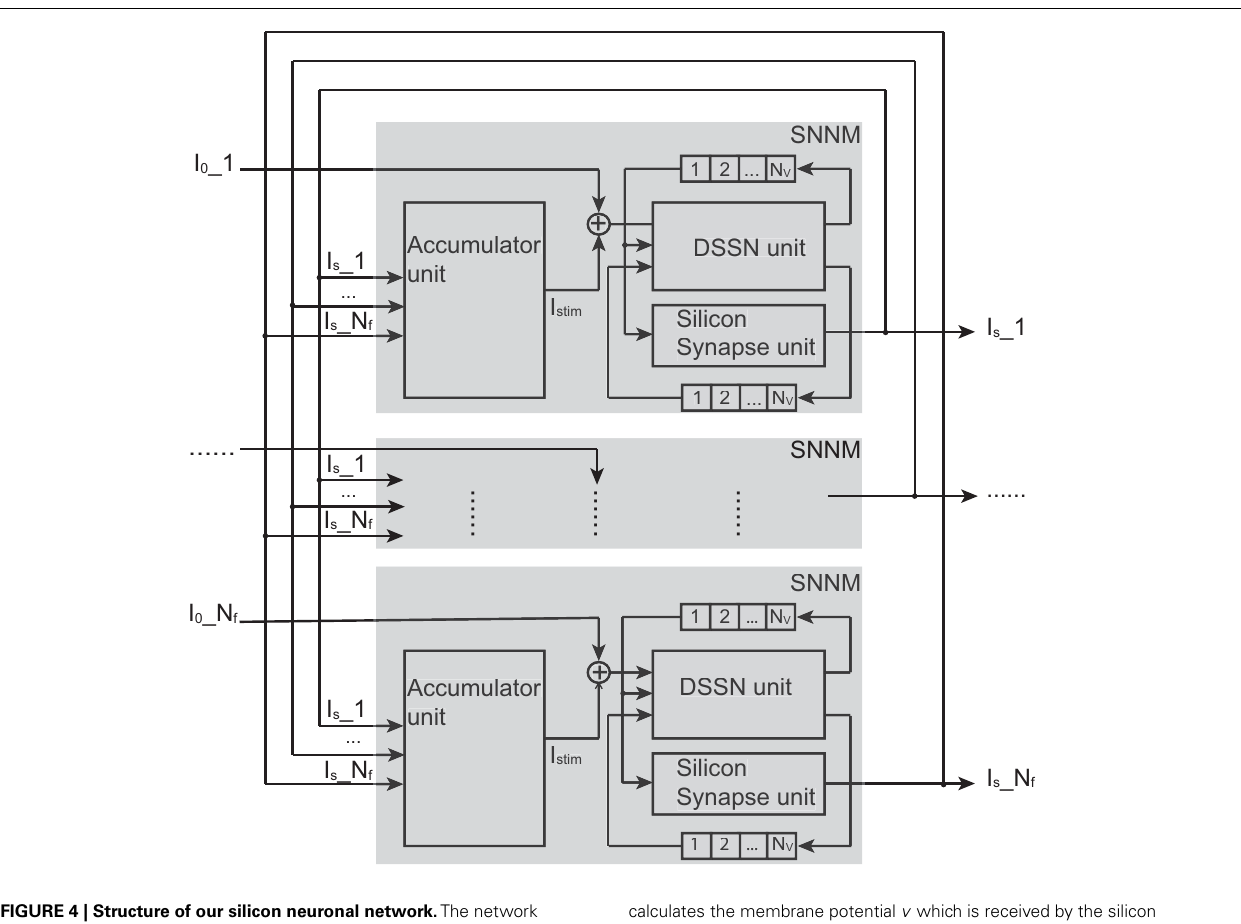
FIGURE 4 | Structure of our silicon neuronal network. The network includes multiple ( N f ) silicon neuronal network modules (SNNMs). An SNNM executes calculation for multiple N v silicon neurons and synapses sequentially.The SNNM is composed of three units: a DSSN, a silicon synapse, and an accumulator units.The DSSN unit